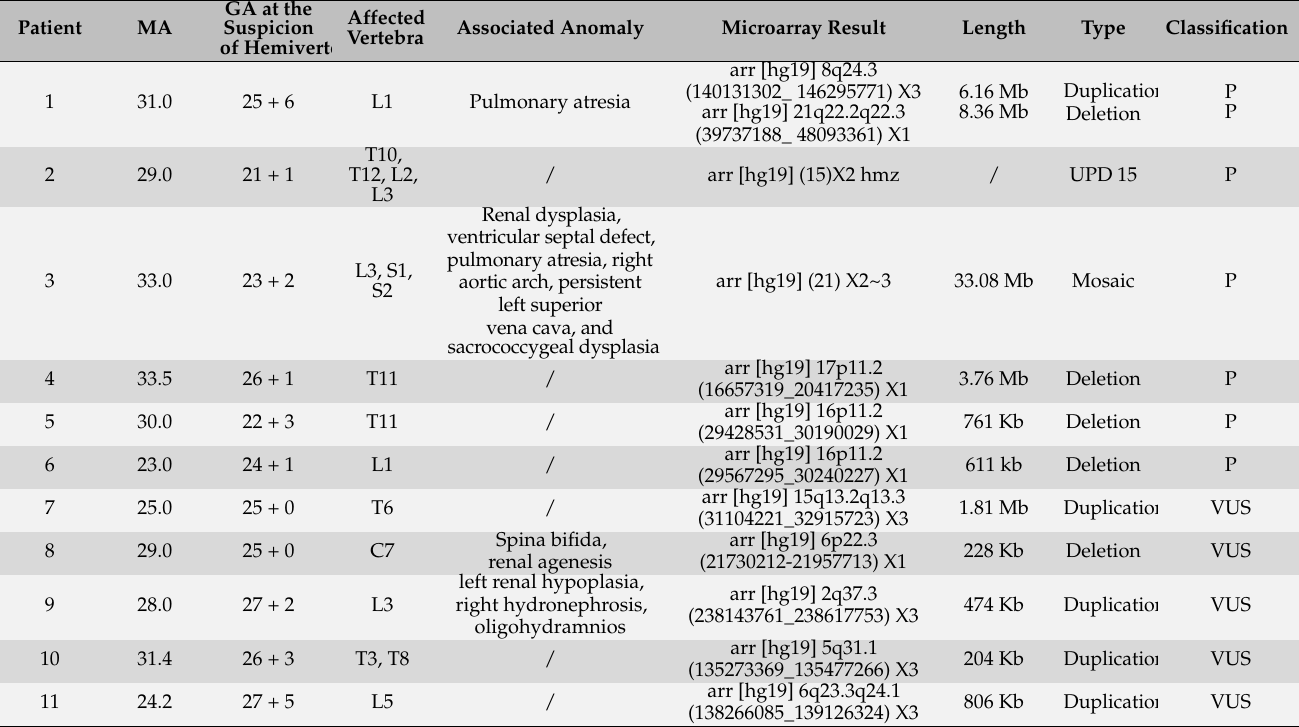
Table 3. Pathogenic copy number variation and VUS identified by CMA in prenatal hemivertebra cases.